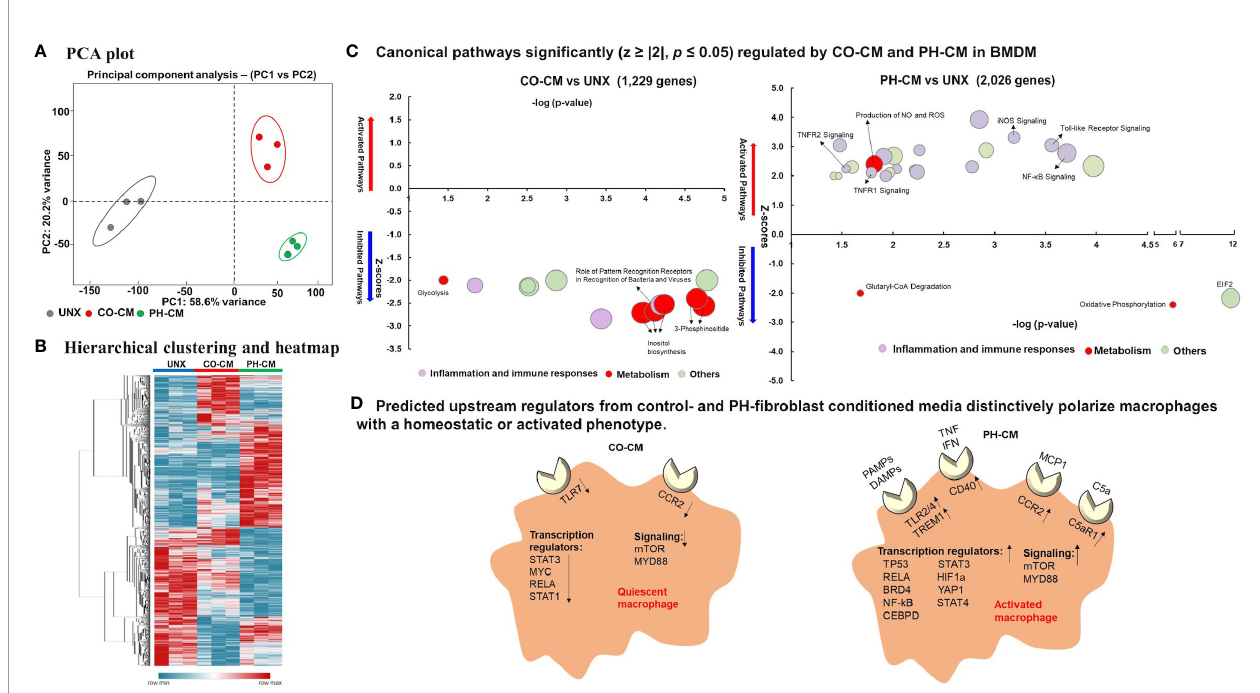
FIGURE 1 | Control and pulmonary hypertensive adventitial fi broblast conditioned media actively, yet differently, regulate macrophage gene pro fi le. Naïve bone marrow derived macrophages (BMDMs) were treated with media conditioned by pulmonary artery adventitial fi broblasts isolated from 2-week old hypoxia induced pulmonary hypertensive (PH-CM) or age-matched control calves (CO-CM), or left untreated (UNX). 12,191 genes met quality control standards and with count greater than 1. (A) Principal component analysis (PCA) showing overall separation of CO-CM and PH-CM treated BMDMs from untreated BMDMs. Each dot represents RNA-Seq data from biologic triplicates. (B) Heat-map showing unsupervised hierarchical clustering of genes from RNA-seq that are uniquely regulated by CO-CM or PH-CM and analyzed by Ingenuity Pathway Analysis (IPA). (C) The signi fi cantly regulated canonical pathways of BMDMs by these genes demonstrated that CO-CM (left) and PH-CM (right) have very different effects on regulating BMDM phenotypes. The pathways were selected with p ≤ 0.05, absolute Z ≥ 2. The size of the bubble indicates the number of genes in that pathway. (D) IPA predicted upstream regulators in CO-CM (left) and PH-CM (right) treated BMDMs (p ≤ 0.05, absolute Z ≥ 2). Upstream Regulators are transcripts, proteins, or metabolites that are predicted based on the downstream targets identi fi ed by RNA-seq. The upstream regulators from CO-CM included: 1) decreased receptors of CCR2 and TLR7, 2) decreased transcription regulators, and 3) decreased signaling pathways. In contrast, the upstream regulators from PH-CM included: 1) increased receptors for pathogen-associated molecular pattern molecules (PAMPs) and damage- associated molecular patterns (DAMPs) (Toll-like receptors, TREM1) and other receptors (CD40, CCR2, C5aR1), 2) increased transcription regulators,